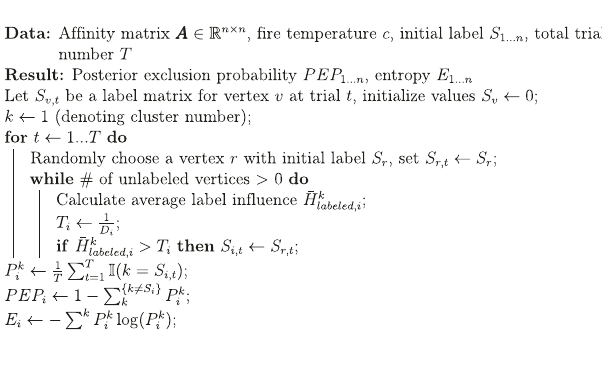
Algorithm 2: Monte Carlo